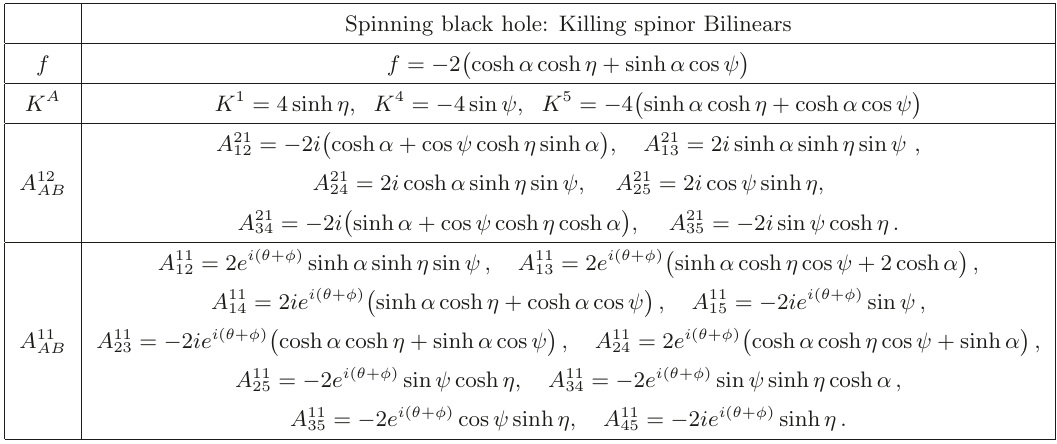
Table 4 . Independent non-zero spinor bilinears for the Killing spinor ǫ 1